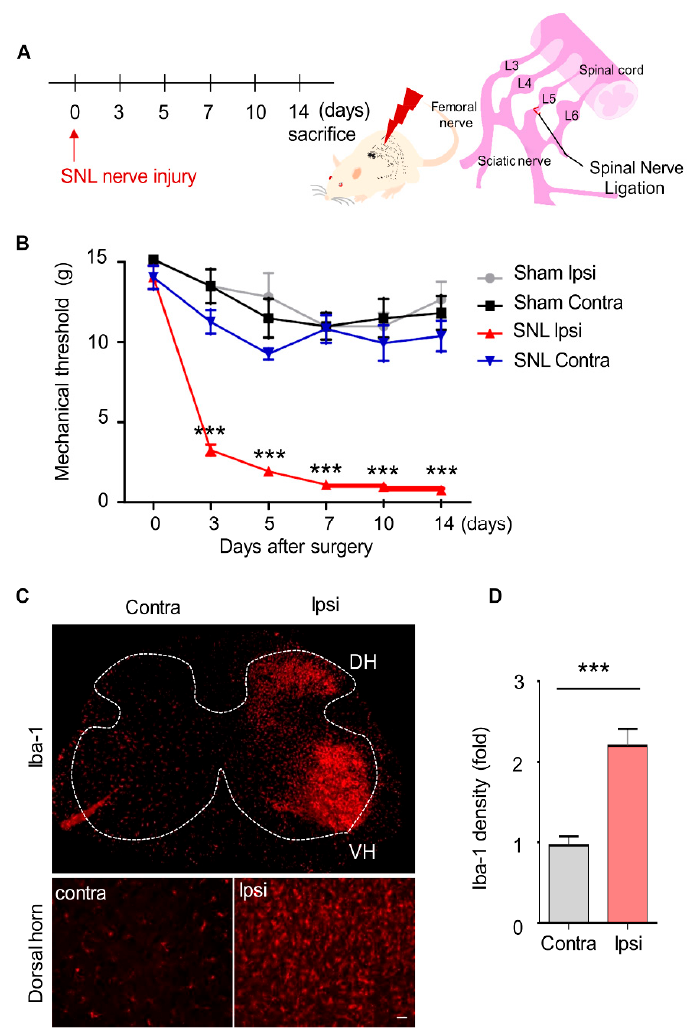
Figure 3. Mechanical allodynia and upregulated microglia activation in spinal nerve ligation-induced rats. ( A ) Neuropathic pain in rats was induced by spinal nerve ligation at the L5 vertebra. ( B ) Afterwards, the rats were subjected to a pain behavior test using von Frey filaments to evaluate the development of neuropathic pain. Data are presented as the mean ± SEM (one-way analysis of variance (ANOVA) with Dunnett’s post hoc test, *** p < 0.001 versus Ipsi), n = 8 per group ( C , D ) At 3 days post-SNL surgery, L5 spinal sections were made and immuno-stained with anti-Iba-1 antibody (a microglia-specific marker). Scale bar = 150 µ m (top), 100 µ m (bottom). Data are presented as the mean ± SEM ( t -test *** p < 0.001 versus Contra), n = 8 per group SNL, spinal nerve ligation; Contra, contralateral; Ipsi, ipsilateral; DH, dorsal horn; VH, ventral